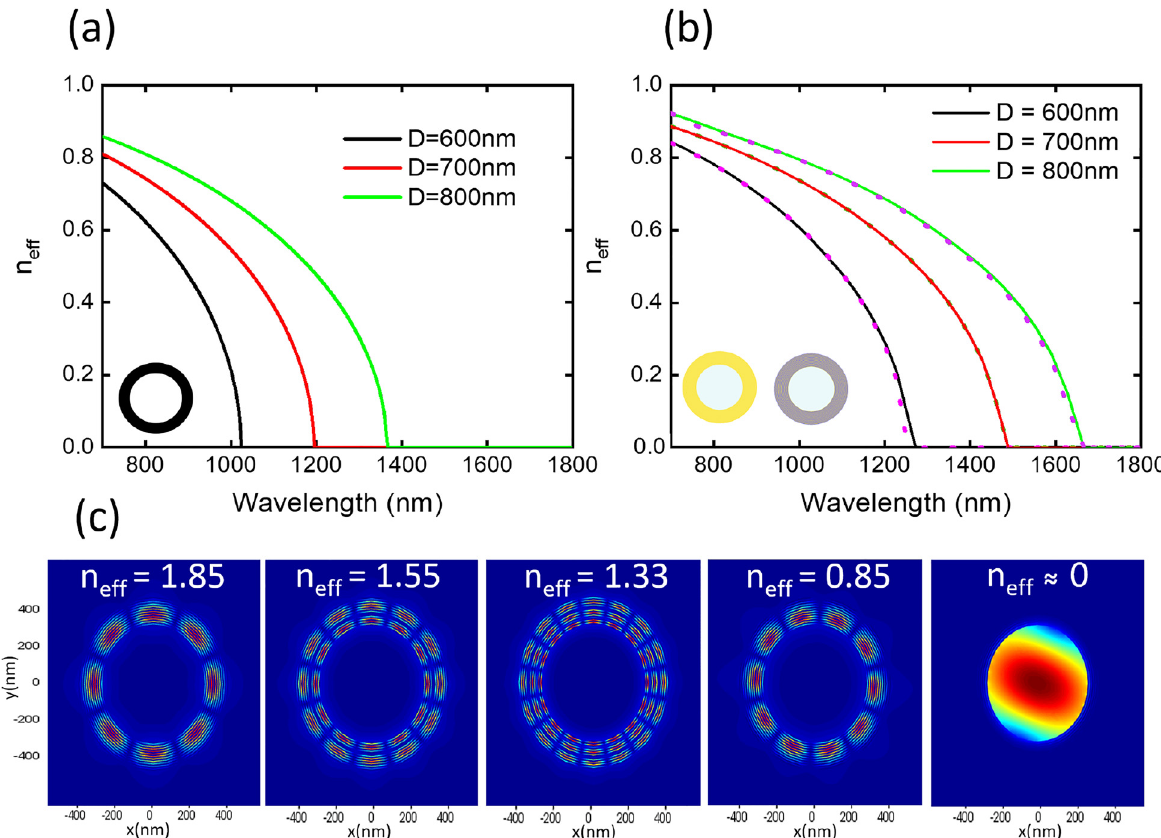
Figure 1: Photonic properties of a cylindrical hollow waveguide and a rolled-up zero-index waveguide with its corresponding mode profiles. (a) The dispersion relation of a cylindrical hollow waveguide with different core diameters D . The schematic of the homogeneous circular waveguide is represented by the black circular inset. (b) The dispersion relation of the rolled-up zero-index waveguide (solid lines). The dotted lines in the same figure show similar dispersion calculated for the cylindrical hollow metallic waveguide. The yellow circular inset represents the cylindrical hollow metallic waveguide and the rolled-up tube is represented by the multilayer gray circular inset. The cutoff wavelength varies as a function of the core diameter D in both figures (top panel). (c) The different mode profiles excited in the rolled-up ≃ 0 depicting the fundamental TE ) with n zero-index waveguide ( D = 700 nm) for different effective indices ( n eff eff 11